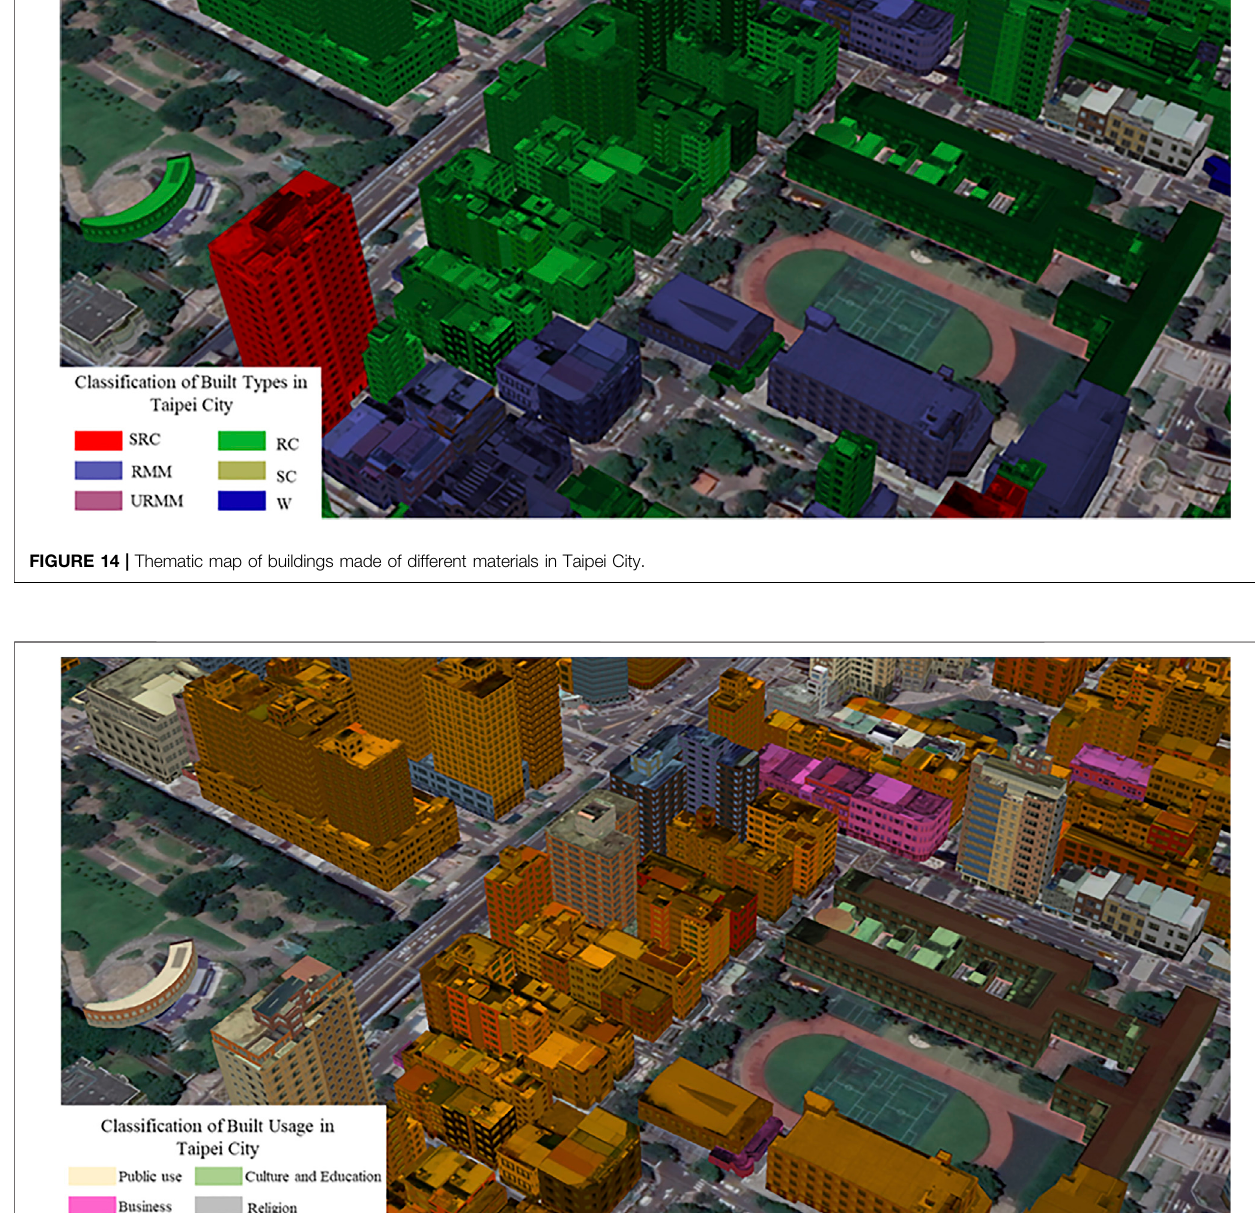
Frontiers in Built Environment |